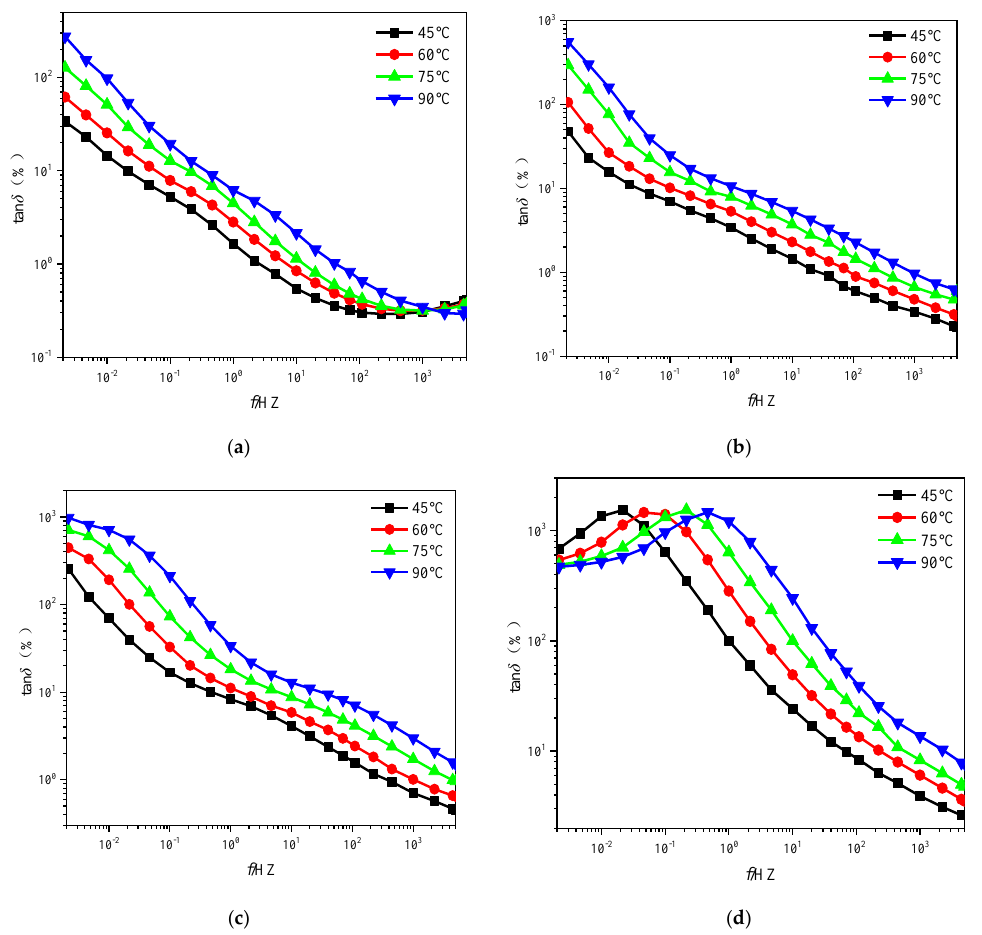
Figure 4. The tanδ curves of unaged pressboard with type I at various test temperatures. ( a ) mc% = 1.3%, ( b ) mc% = 2.3%, ( c ) mc% = 3.1%, ( d ) mc% = 4.4%.